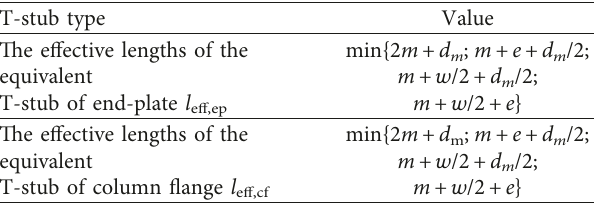
Table 8: Effective length of the equivalent T-stub.